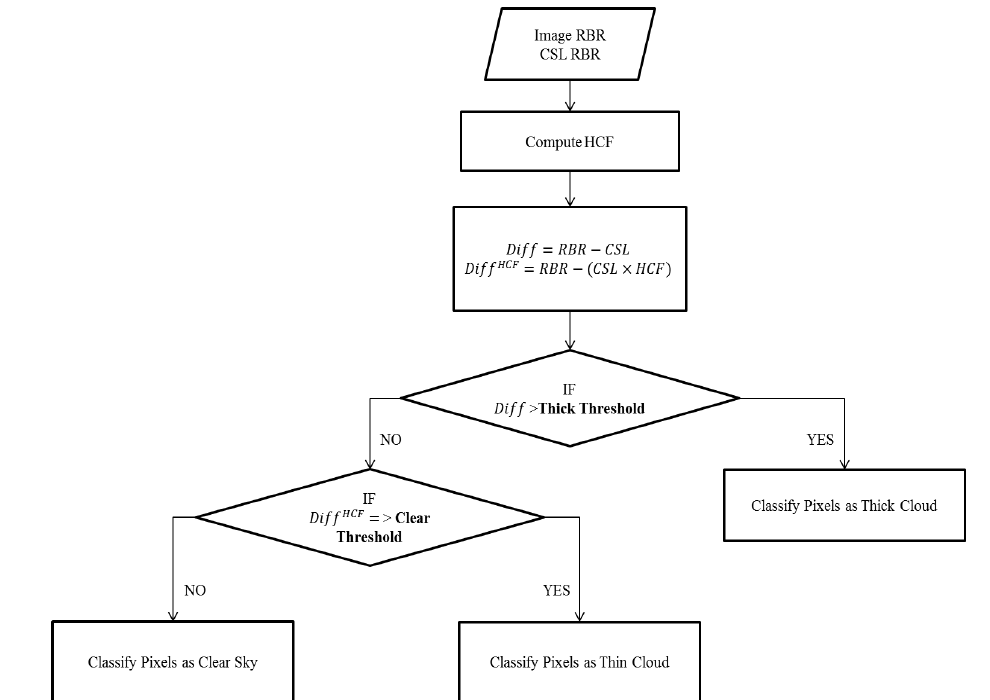
Figure 6. Flowchart of the CDOC algorithm which is executed pixel-by-pixel. Note that thick clouds are determined based on the Diff in Eq. (5) while the distinction between clear sky and thin clouds is based on the Diff HCF in Eq. (6). A similar process is applied for the perturbation ratio (Eqs. 7 and 8).